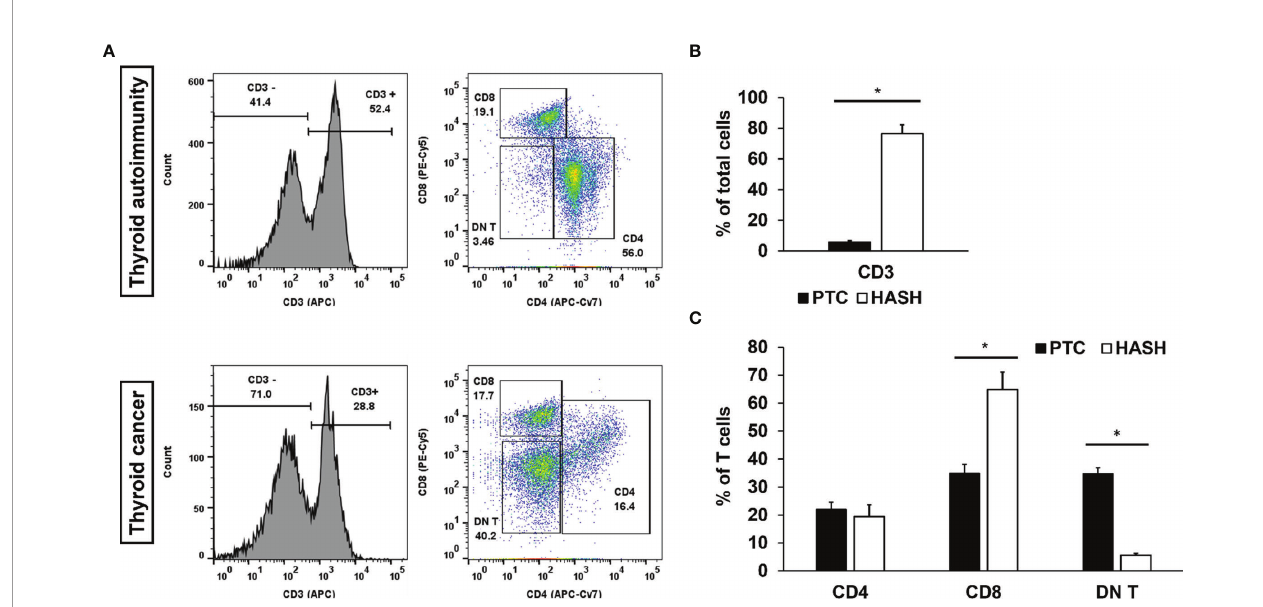
FIGURE 2 | Flow cytometry of Fine Needle Aspiration (FNA) aspirates ’ T cells. Histogram of leukocytes and pseudo-color dot plots of lymphocyte specimens from the representative FNA aspirate of the patient with papillary thyroid cancer and hypothyroid Hashimoto thyroiditis (A) and bar graphs of statistical analysis of CD3 (B) CD4, CD8, and DN T (C) [papillary thyroid cancer (PTC), n = 53; Hashimoto (Hash), n = 24]. First, specimens were gated for CD3 and subsequently sorted for CD4, CD8, and DN T. DN T stands for (CD3 + CD4 - CD8 - ) T cells. Black bars represent results for FNA specimens from PTC patients, and white bars represent results for FNA specimens from hypothyroid Hash patients. Statistical signi fi cance was determined by using t-test: two samples assuming unequal variance (p < 0.05) between the groups. Signi fi cance (*) p <